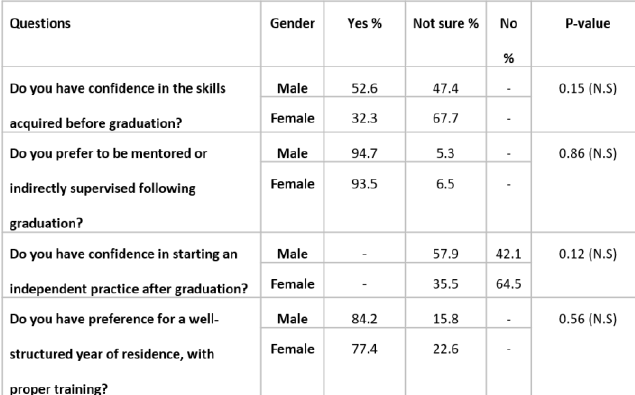
Table 11: Practice readiness based on gender among